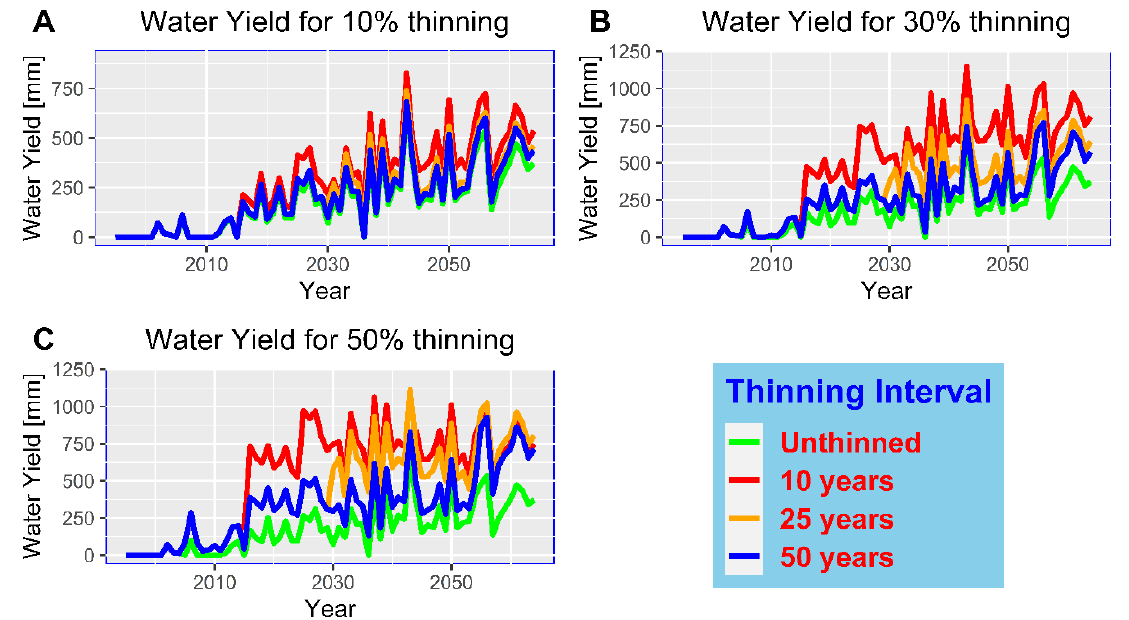
Figure 4. Water Yield for ( A ): 10%, ( B ): 30%, and ( C ): 50% thinning in different thinning